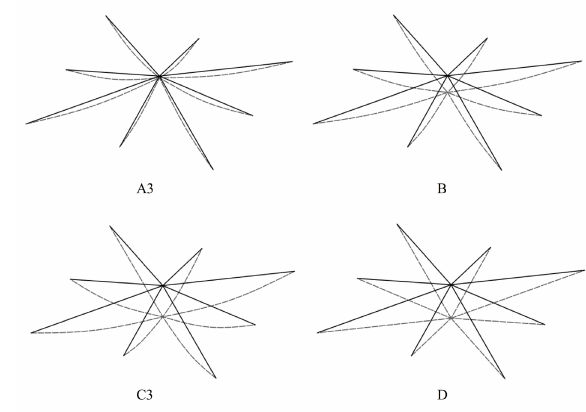
Figure 4: Eight-member structure load-displacement curve